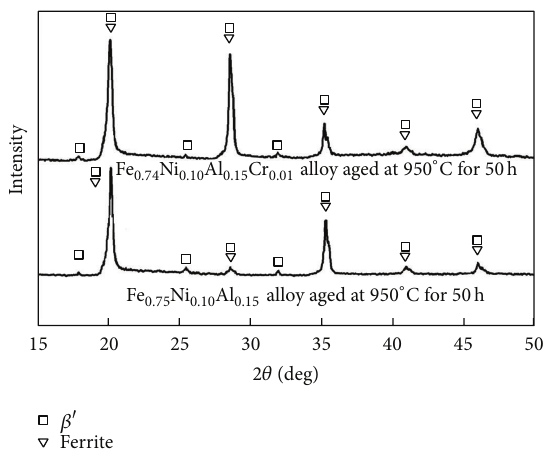
Figure 3: XRD diffractograms of the Fe 0.75 Ni 0.10 Al 0.15 and